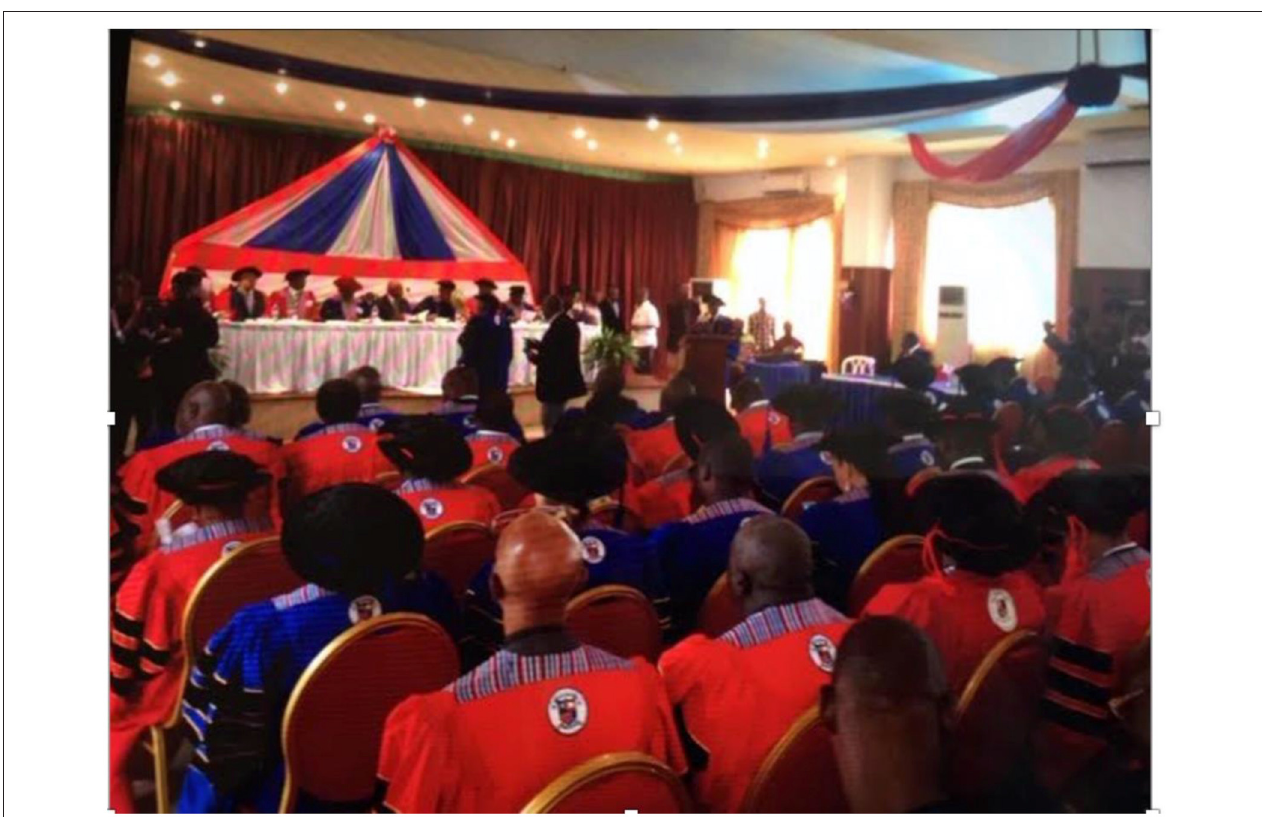
FIGURE 1 | Historic residency graduation September 15, 2017. Graduates in red (shown in front) Ob/Gyn graduating residents, Faculty in Blue: Fellows of the West African College of Physicians, Faculty in Red: Fellows of the West African College of